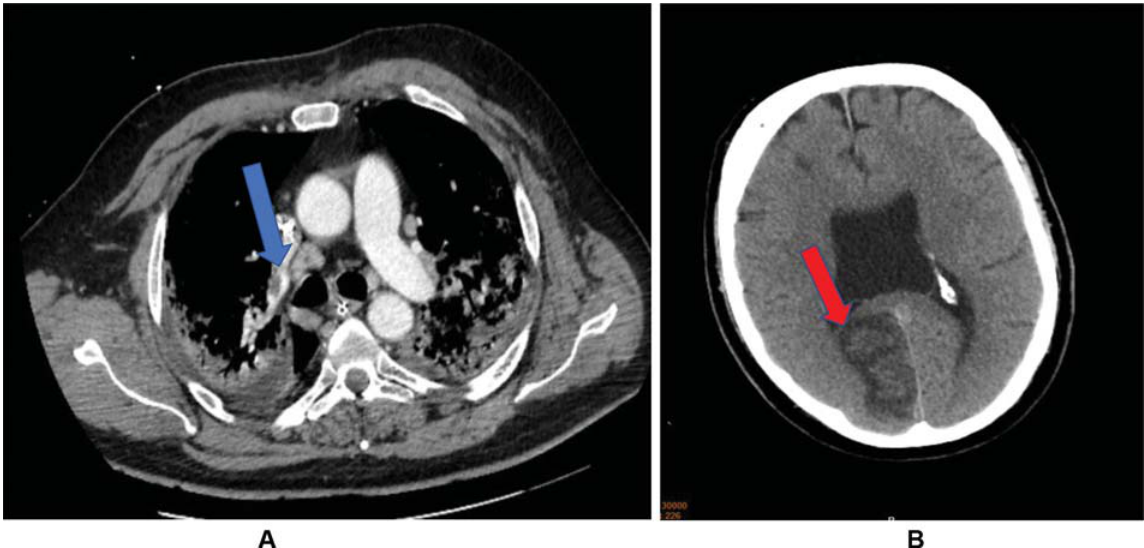
Fig. 4 ( A ) Pulmonary CTscan depicting one of several pulmonal arterial thrombi (right pulmonary subsegment artery, blue arrow). ( B ) Cerebral CT scan with evidence of a subacute right posterior territorial ischemic lesion (red arrow). CT, computer